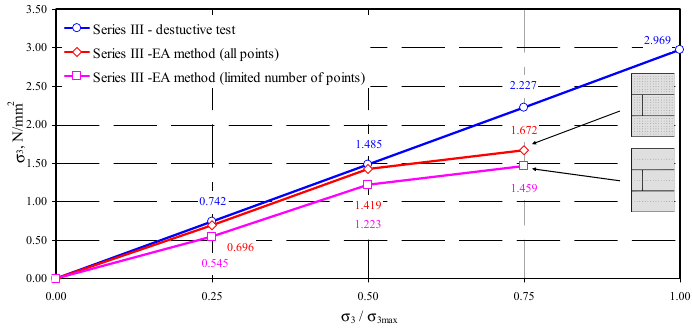
Figure 16. Measurement results of stress in the model III-1.